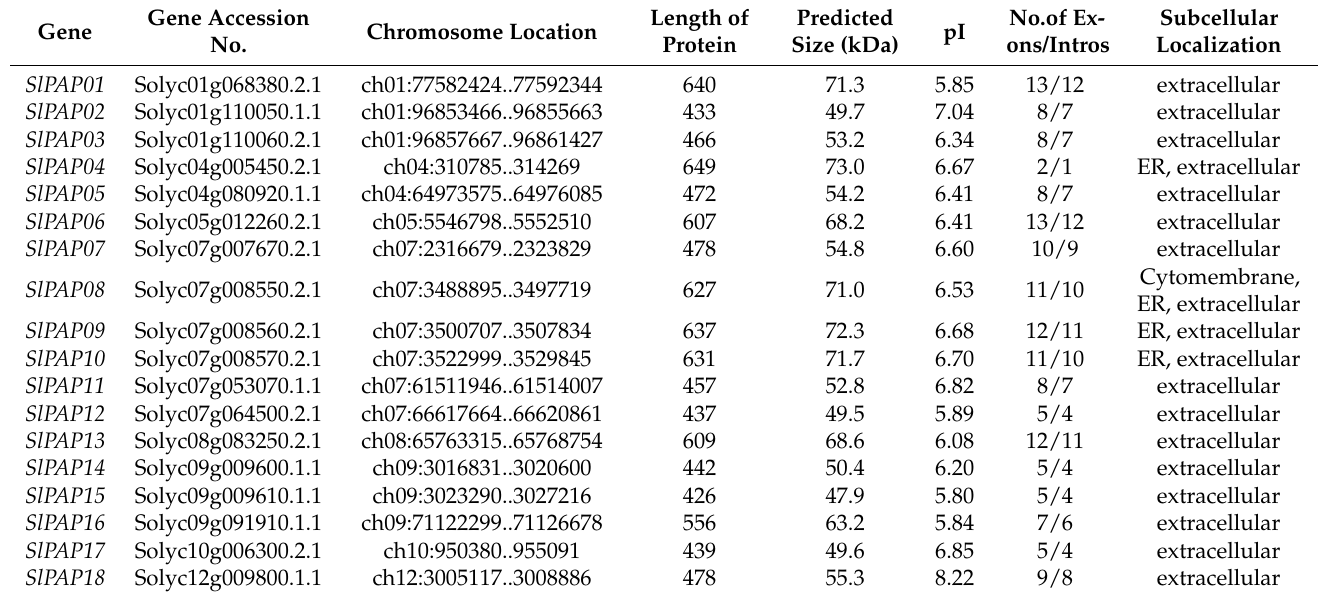
Table 1. General information about the 18 SlPAP s